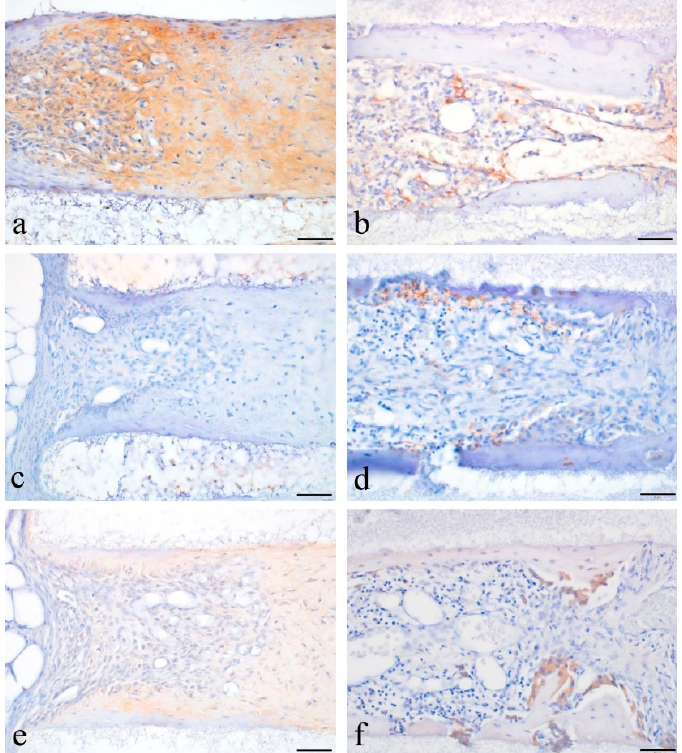
Figure 3. IHC images of formed hard tissues. ( a ) DSP localization in the tissues of the experimental group. ( b ) DSP localization in the tissues of the control group. ( c ) RANKL localization in the tissues of the experimental group. ( d ) RANKL localization in the tissues of the control group. ( e ) CD68 localization in the tissues of the experimental group. ( f ) CD68 localization in the tissues of the control group. The scale bar indicates 50 μ m.